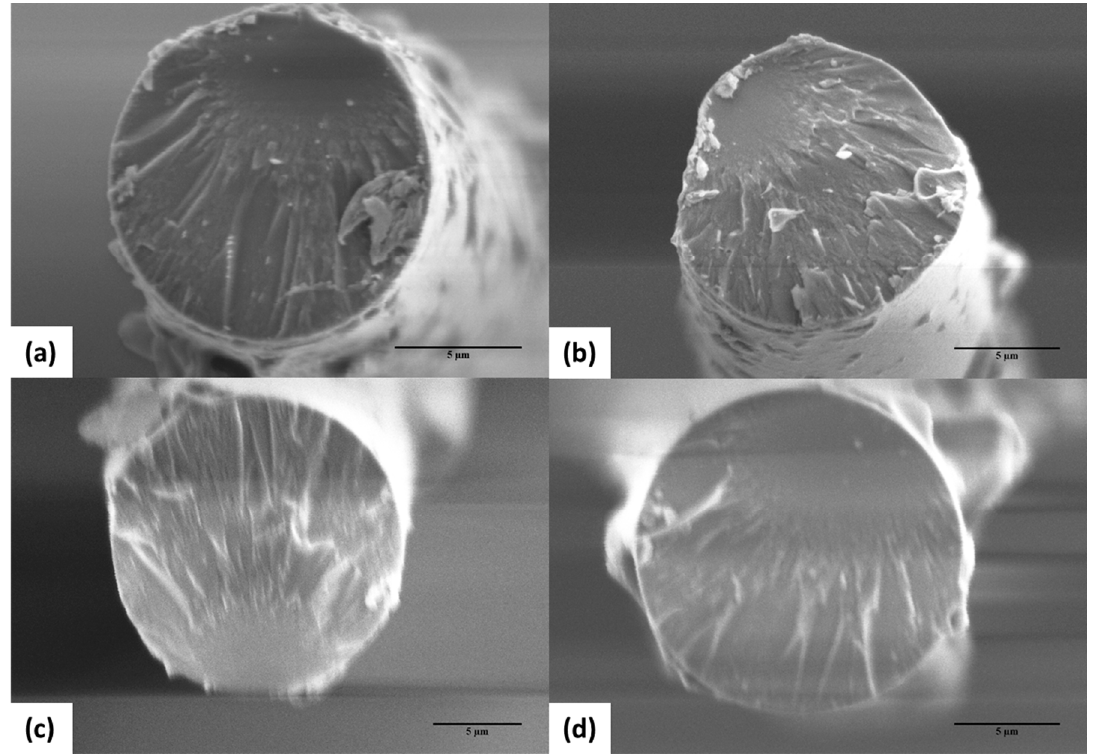
Figure 6. SEM images of example fracture surfaces observed from recovered pyrolyzed filaments: ( a , b ) SMC samples; ( c , d ) wind blade samples. Images captured with a Hitachi S-3400N SEM.